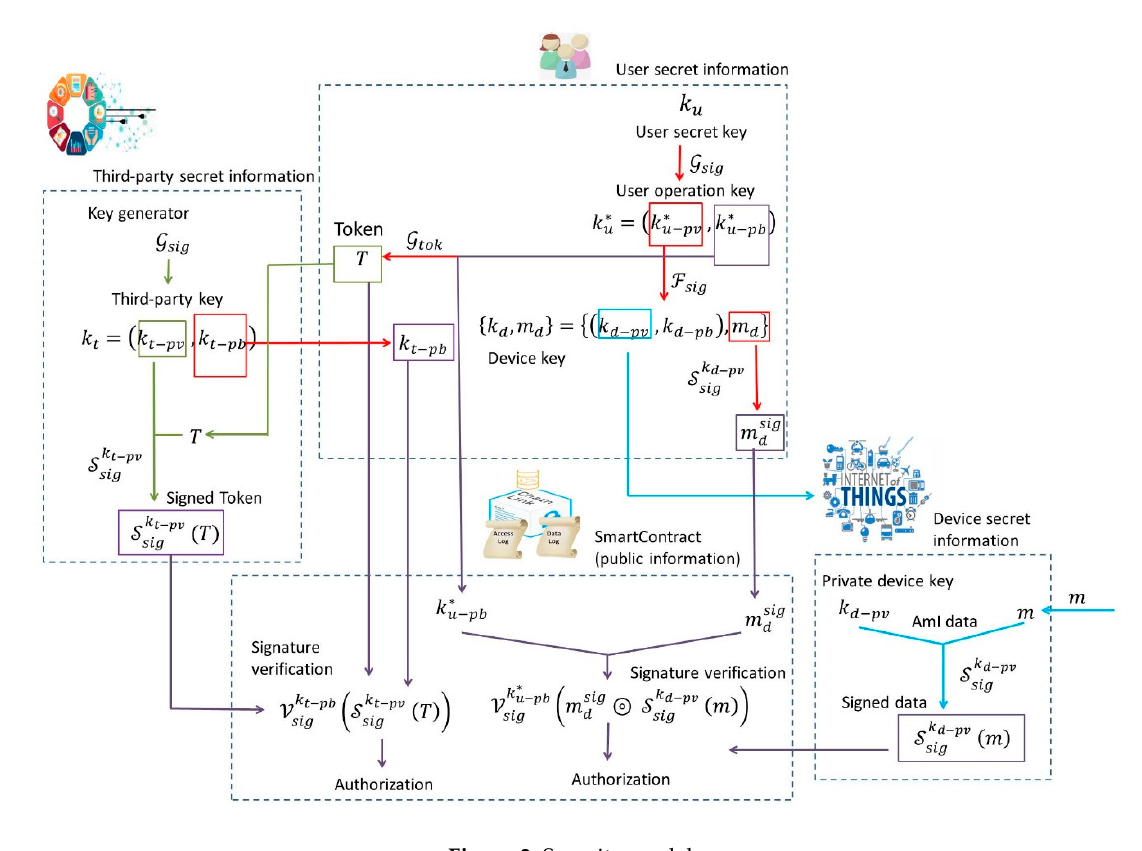
Figure 3. Security